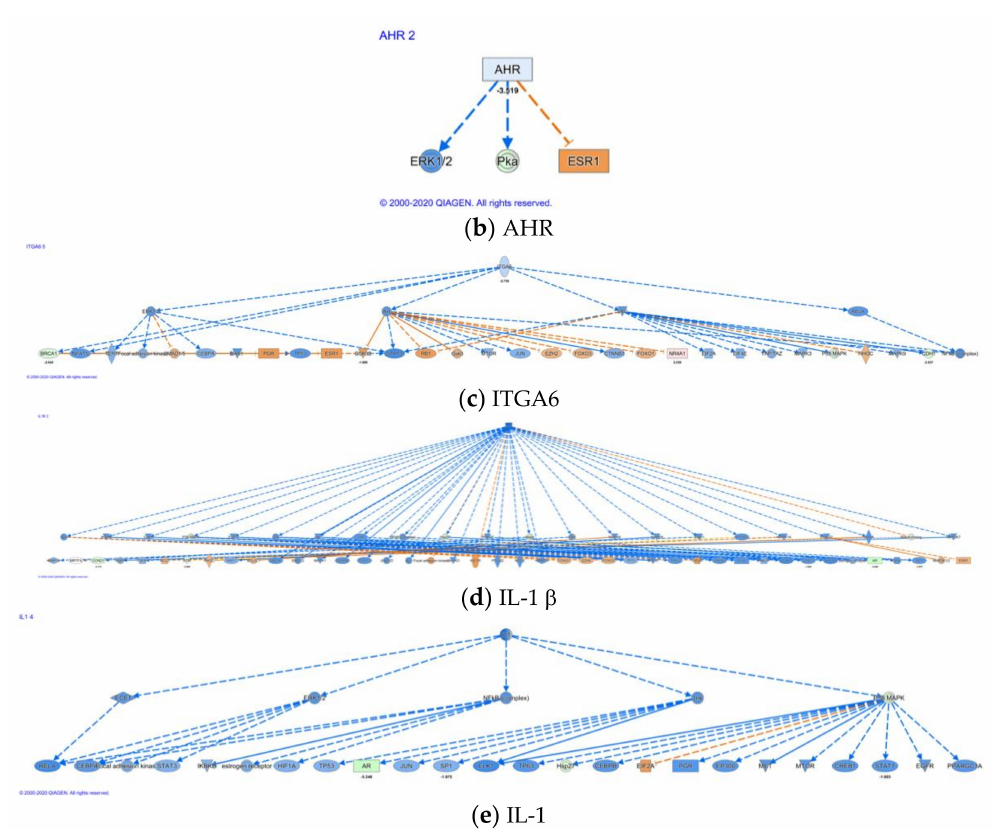
Figure 2. Casual network for AR, AHR, ITGA6, IL-1 β , and IL-1. Casual network analysis was performed using IPA as described in Materials and Methods. The diagram depicts interaction with other regulators: ( a ) AR, ( b ) AHR, ( c ) ITGA6, ( d ) IL-1 β , and ( e )